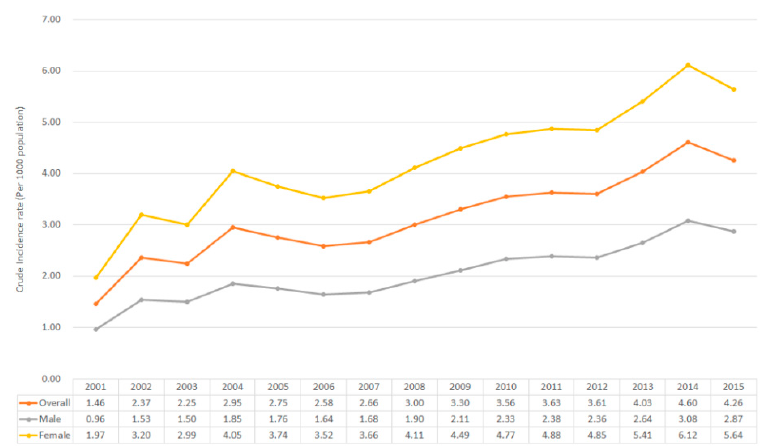
J. Clin. Med. 2019 , 8 , x FOR PEER REVIEW Figure 1. Crude incidence (per 1000 population) of DED by year and gender. Figure 1. Crude incidence (per 1000 population) of DED by year and gender.